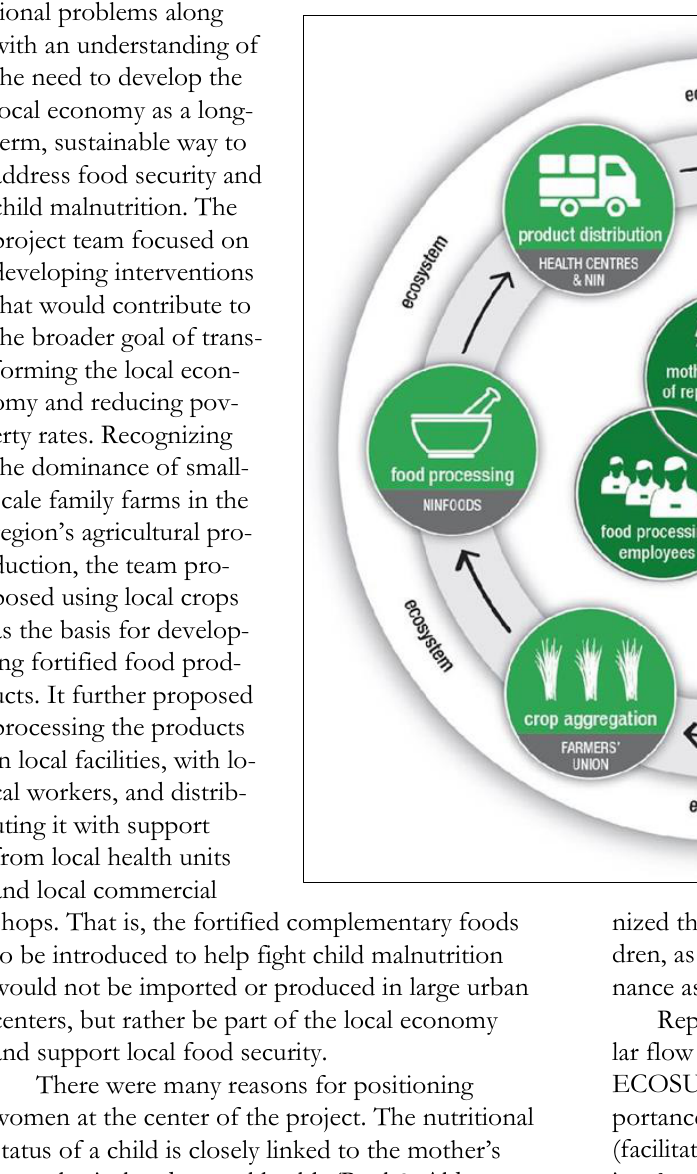
Figure 2. ECOSUN’s Conceptual